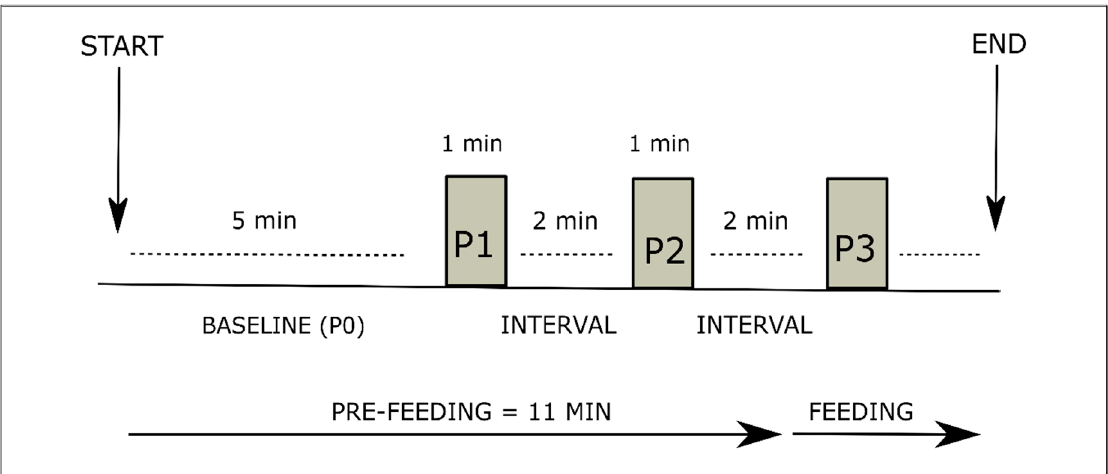
Figure 1. Assessment sequence. Prefeeding consisted of baseline period (P0, five minutes); period 1 (P1, one minute), corresponding to smell exposure in intervention group; period 2 (P2, one minute), corresponding to taste exposure in intervention group; and feeding period (P3, duration according to feeding volume).